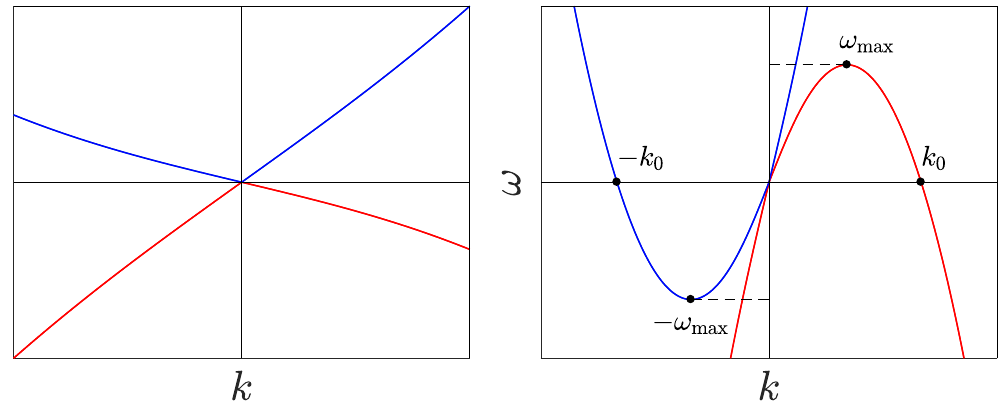
Figure 1. Schematic plot of the Bogoliubov–de Gennes (BdG) dispersion relation for a subsonic (left) and a supersonic (right)